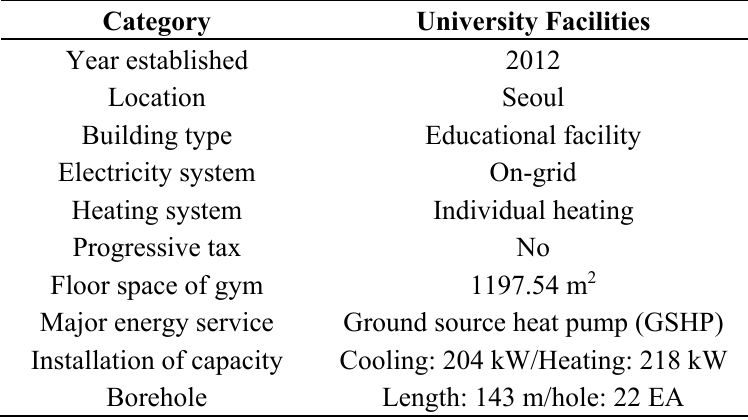
Table 2. Overview of Target